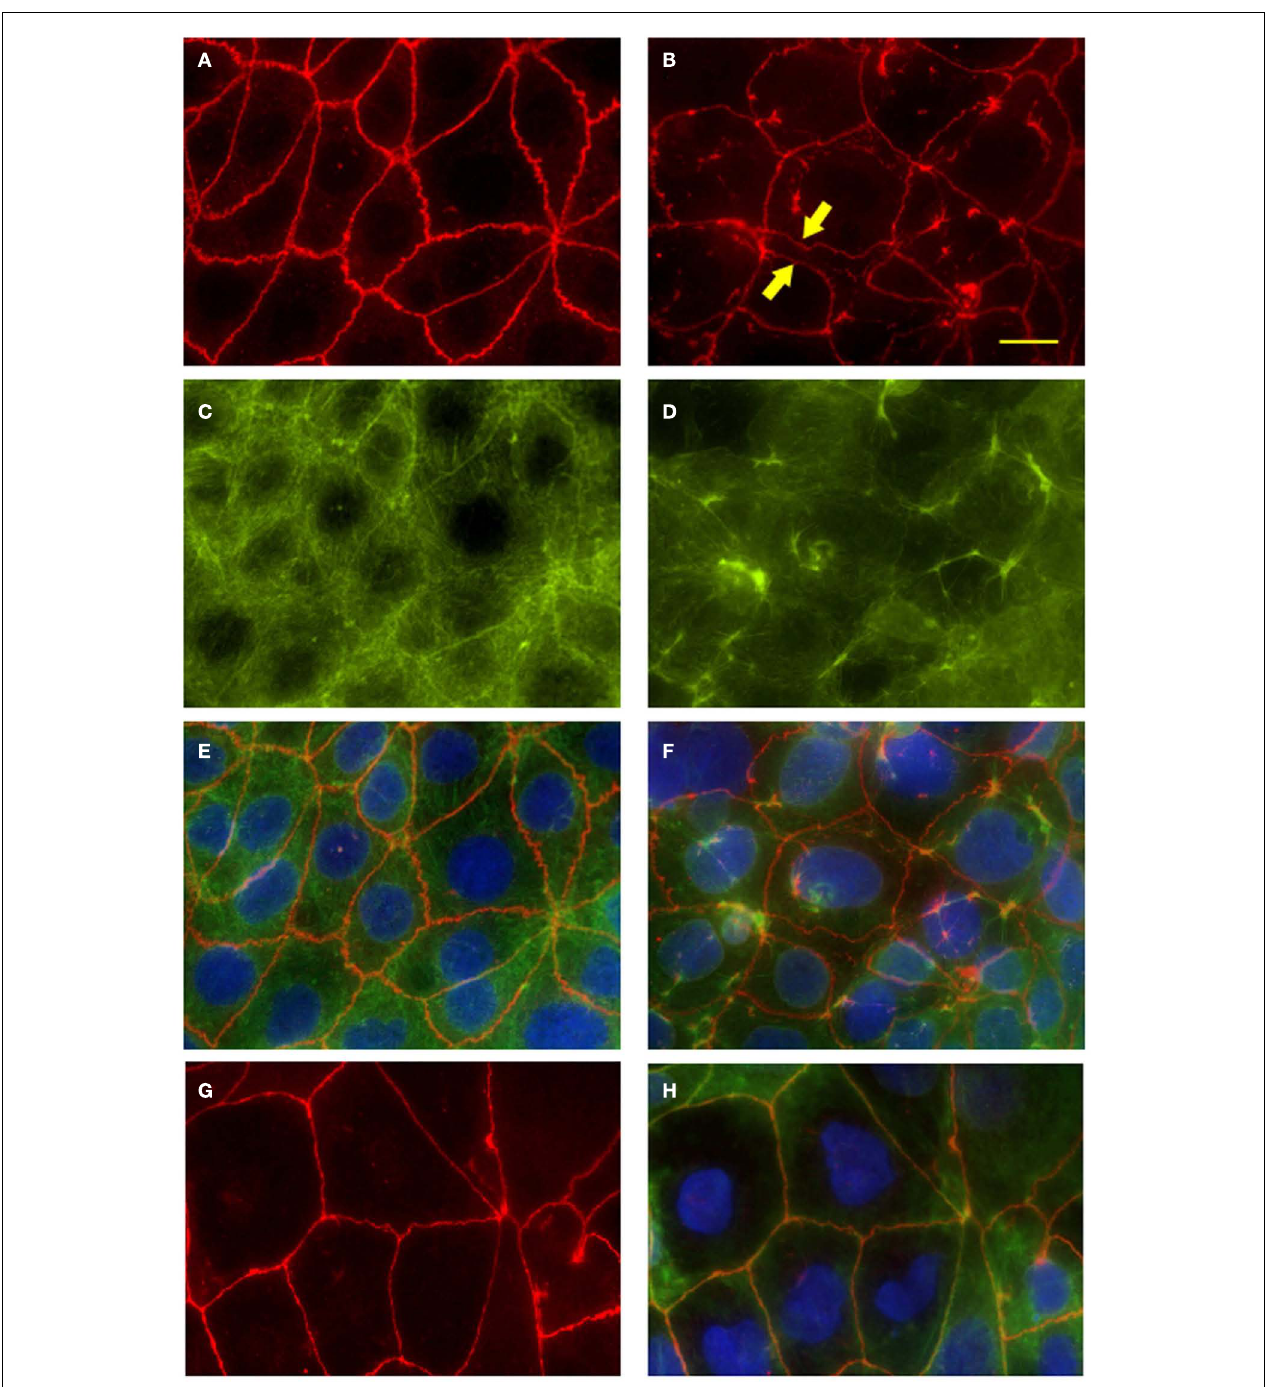
ZO-1organization in wild-type S .Typhi -infected monolayers. Areas of cell-cell detachment are marked by arrows. (C) Actin staining of the cytoskeleton in uninfected controls. (D) Actin fibers stained in the S . Typhi -infected cells. (E) Merge of (A,C) . (F) Merge of (B,D) . (G) ZO-1 distribution in CVD 909 infected monolayers. (H) ZO-1 (red), actin (green) and DAPI for the nuclei (blu) merged staining of CVD 909 infected cells. Bar, 25 µ